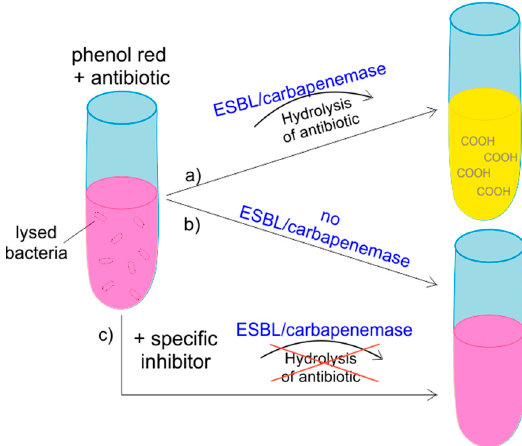
Figure 3. Principle of colorimetric assays for detection of ESBLs and carbapenemases. The test isolate is lysed and incubated in phenol red solution with an antibiotic. ( a ) If the test isolate is positive for ESBL/carbapenemase production, the enzyme hydrolyzes the antibiotic, resulting in a pH shift and a color change from magenta to yellow. ( b ) ESBL/carbapenemase-negative isolates do not induce a change in color. ( c ) Addition of enzyme-specific inhibitors prevents hydrolysis of the antibiotic, and no color change is